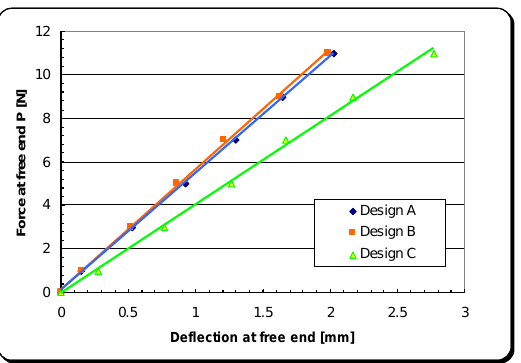
Figure 20. Stiffness test results for the cantilever-DPT assembly for the loading condition shown in Figure 15.